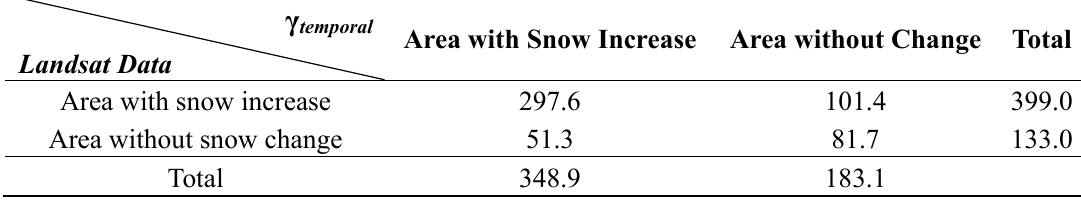
Table 5. Spatial comparison of snow maps derived from coherence 20080222–20080408 pair and 20080209–20080404 Landsat 5 TM pair. Unit: km 2 .